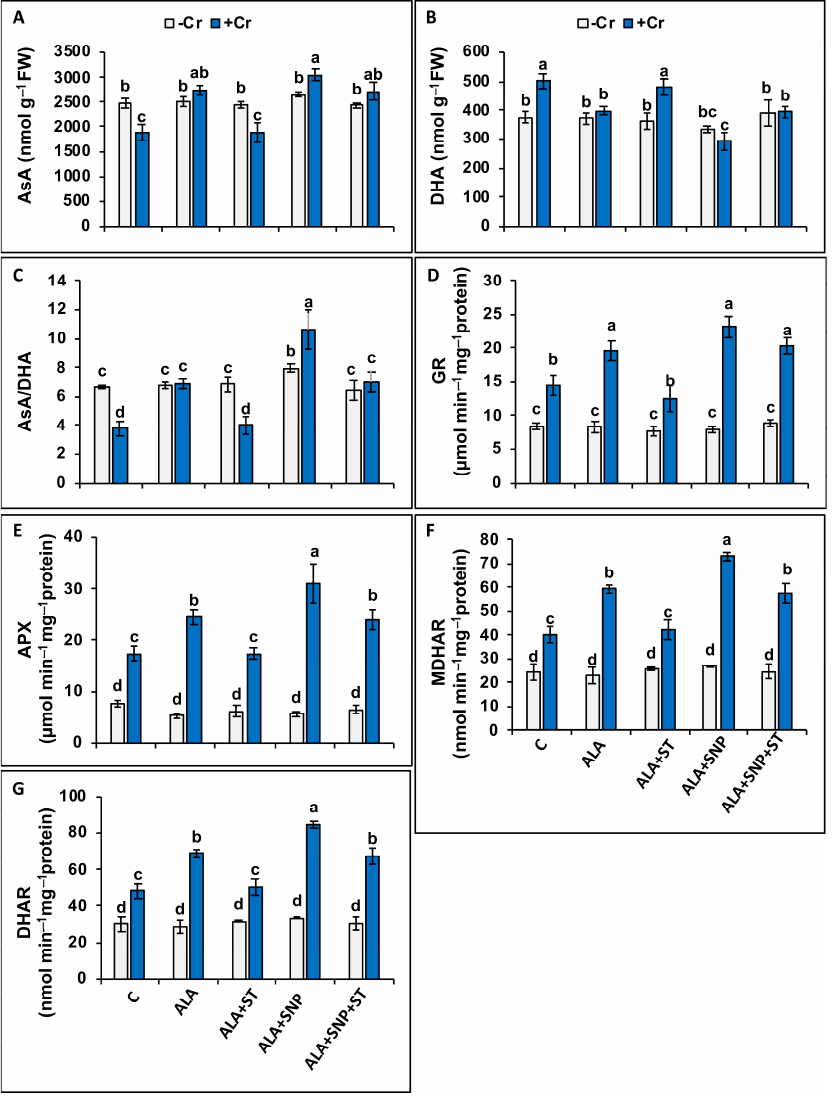
Figure 7. Ascorbate (AsA) ( A ), dehydroascorbate (DHA) ( B ), AsA/DHA ratio ( C ), activities of glutathione reductase (GR) ( D ), ascorbate peroxidase (APX) ( E ), monodehydroascorbate reductase (MDHAR) ( F ), and dehydroascorbate reductase (DHAR) ( G ) in Cr-treated (+Cr) and non-treated ( − Cr) tomato seedlings sprayed with 20 mg L − 1 5-aminolevulinic acid (5-ALA) , 0.1 mM sodium tungstate (ST) + 5-ALA, 5-ALA + 0.1 mM sodium nitroprusside (SNP), or 5-ALA + SNP + ST. Data are means ± S.E, different lower-case letters on bars reflect that mean values differ significantly at p ≤ 0.05.